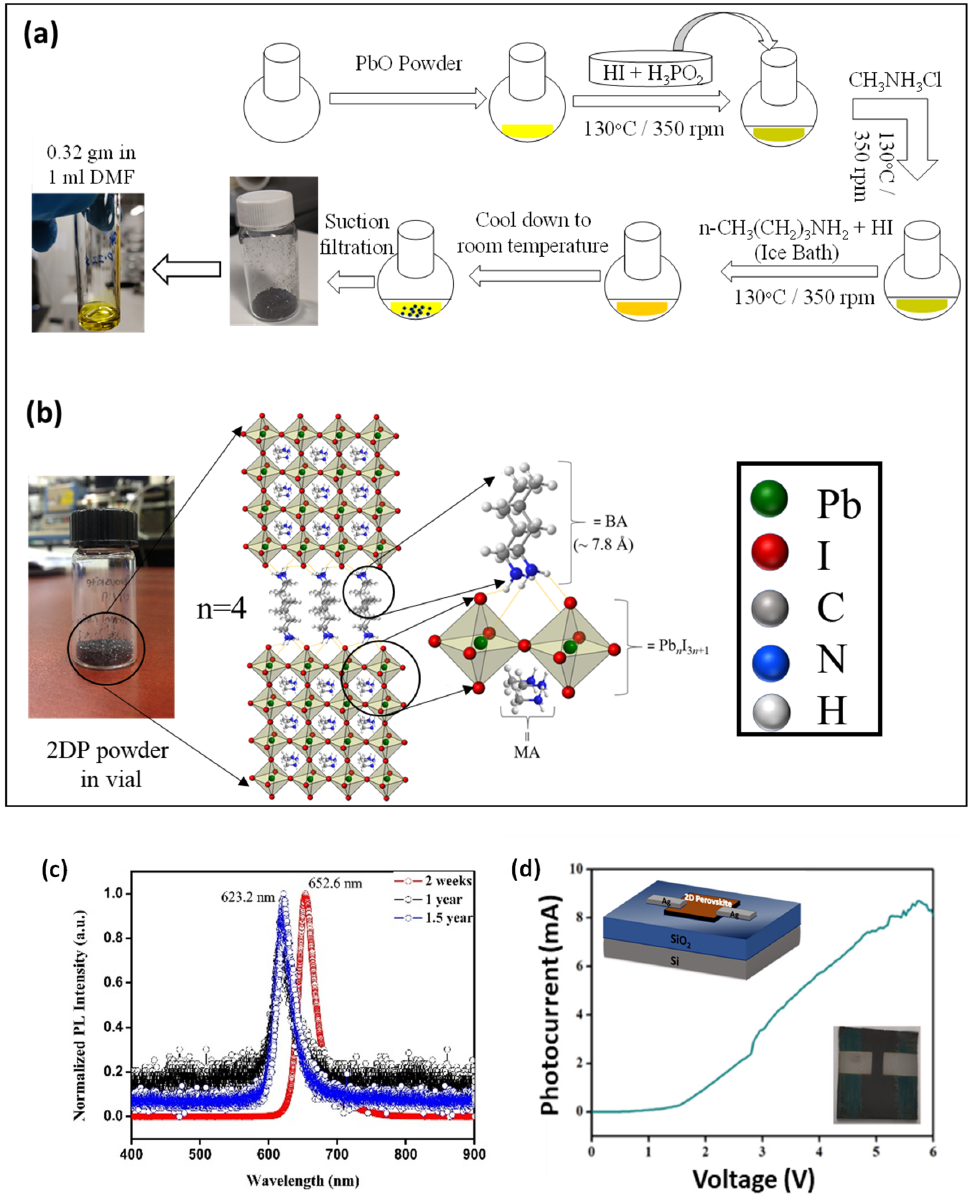
Figure 1. ( a ) Synthesis process of 2DP ((CH 3 (CH 2 ) 3 NH 3 ) 2 (CH 3 NH 3 ) 3 Pb 4 I 13 ) powder using the precursors shown. ( b ) Synthesized 2DP powder in a vial ( left ), and the concomitant crystalline structure for the n = 4 formulation ( right ). ( c ) The inherent stability of the 2DP powder was gauged using steady ‐ state PL measurements, gathered over the course of 1.5 years, for crystals stored at ambient temperatures in a desiccator. A slight blue shift of 29 nm in the peak position with time was evident, but the crystals were still photoactive with a well ‐ defined emission peak, and a FWHM that was largely unchanged over the 1.5 years of observation time. ( d ) The 2DP crystals were dispersed in solution and spin cast into thin films on an oxidized Si substrate with metal electrodes that were deposited using a shadow mask. Here the I p was measured as a function of voltage and the top inset shows the schematic of the device, with the fabricated version of the device seen in the bottom inset. As noted previously, one of the advantageous features of 2DPs is their higher stabil ‐ ity, given that the slow loss of the MA + cation in MAPbI 3 films gradually leads to its dis ‐ solution to the yellow PbI 2 phase after exposure to moisture ‐ rich ambient environments,